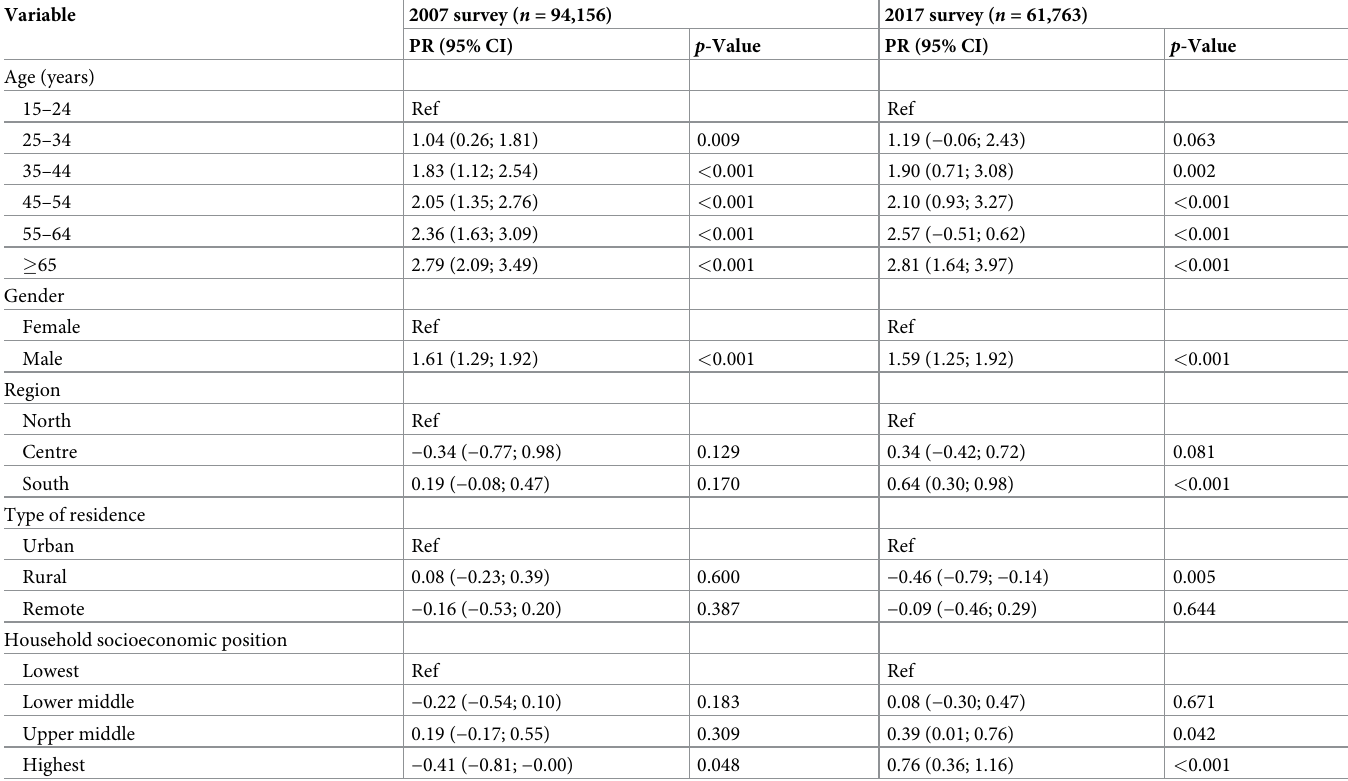
Table 2. Associations between individual- and household-level variables and tuberculosis prevalence at each timepoint (2007 and